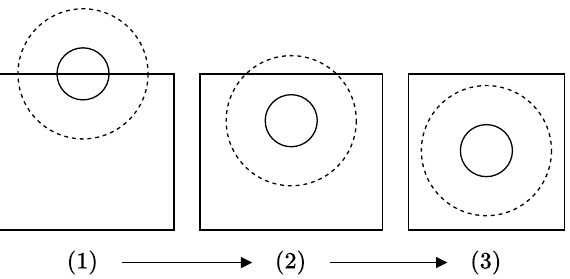
Figure 2. An illustration of three iterations of the zone modification algorithm in a fictitious two dimensional space. The rectangle represents the original target zone, the circle with solid line represent the ellipsoidal invariant set and the circle with dashed lines represent the ε B enlargement of the ellipsoidal invariant set. The algorithm terminates in the third step when the ε B -enlarged ellipsoidal invariant set does not intersect with the set outside the target